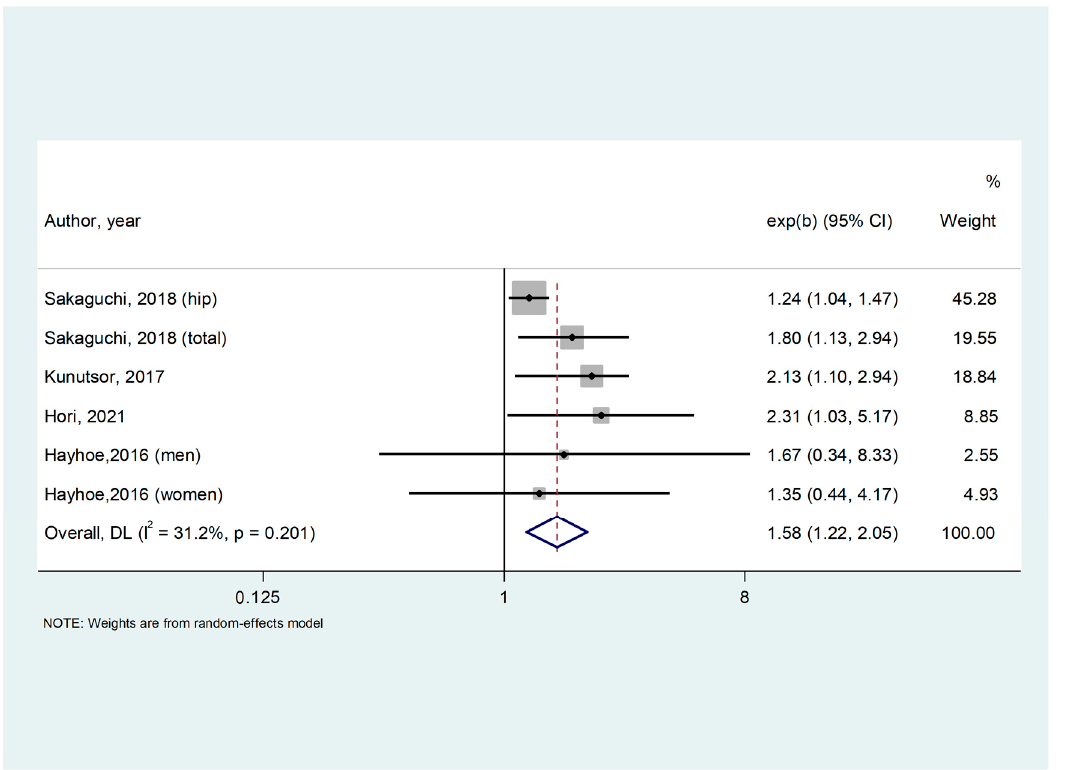
Figure 2. Forrest plot of association between low serum magnesium and incident fractures [29–32].